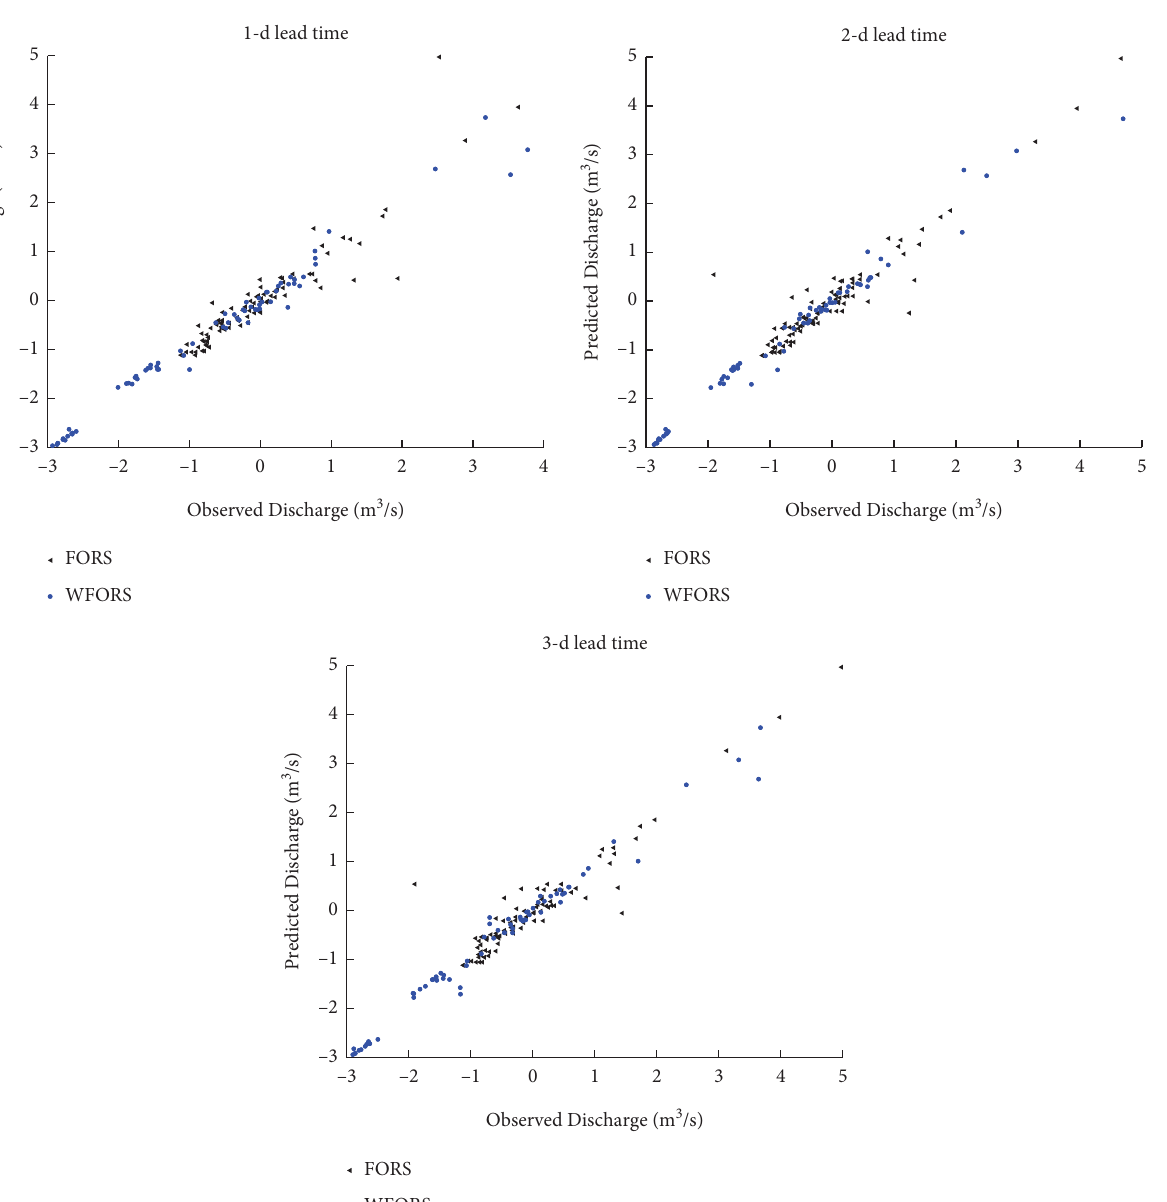
Figure 6: Represents scatter diagram of the observed reservoir fow against the predicted reservoir fow of FORS and WFORS